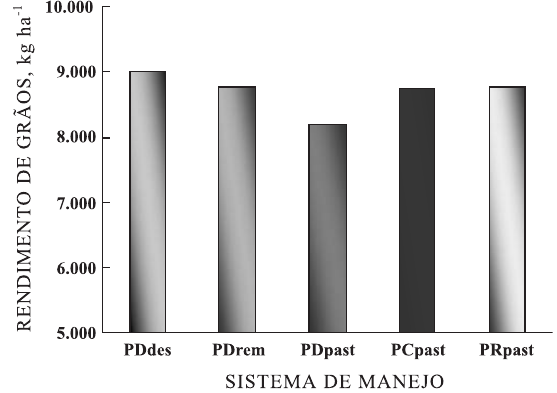
Figura 1. Rendimento de grãos de milho nos sistemas de manejo na integração lavoura-pecuária. Otacílio Costa - SC,